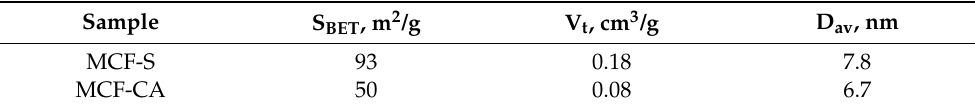
Figure 2. Adsorption–desorption isotherms and pore-size distribution of the spinel ferrite samples. Table 1. Texture parameters of the synthesized spinel